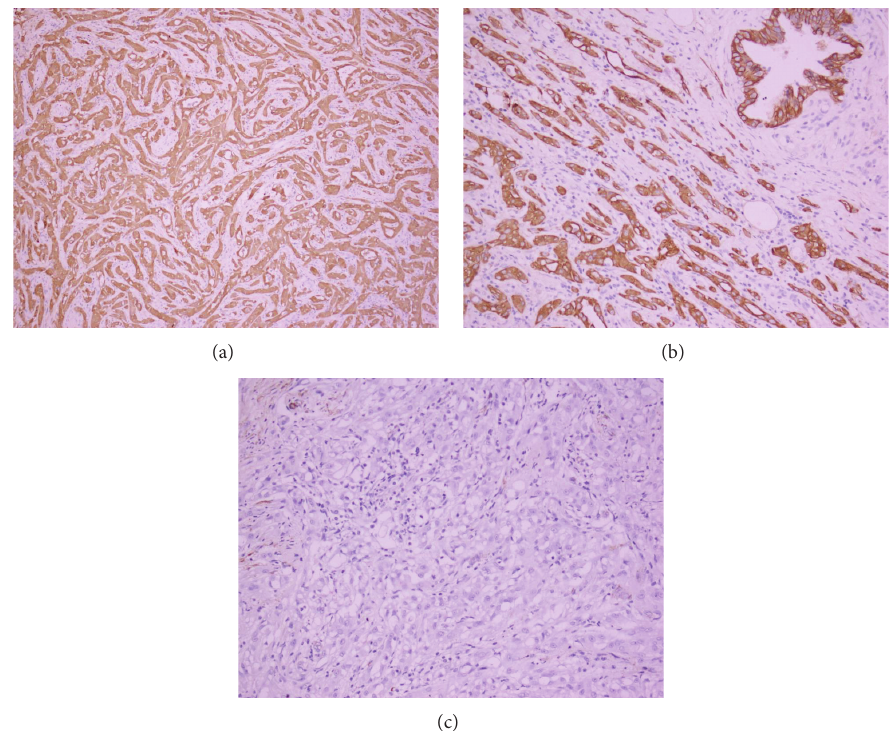
Figure 3: Immunostaining of adenomatoid tumors. (a) Calretinin (+); (b) cytokeratin (+); (c) vimentin (+) ( × 200).